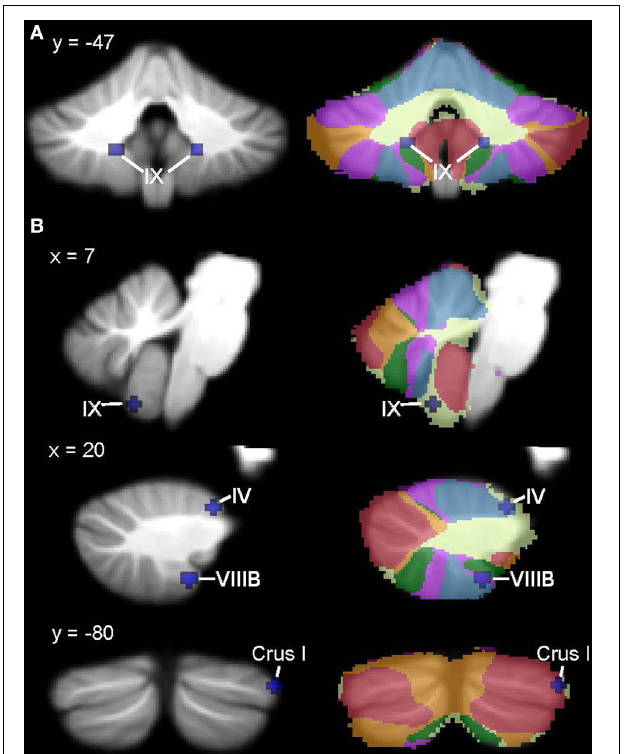
FIGURE 3 | ASD cerebellar ROI analysis. Left, ASD < TD in additional IX and right Crus I clusters (red) and regions where ASD > TD (violet) in the right dentate nucleus and bilaterally in VIIB. These ALE maps are thresholded at FDR-corrected p < 0 . 05, k > 50. Right, corresponding slices showing functional connectivity maps of the cerebellum (Buckner et al., 2011). Networks are color-coded such that blue, somatomotor; green, dorsal attention; violet, ventral attention; cream, limbic; orange, frontoparietal; red, default network.